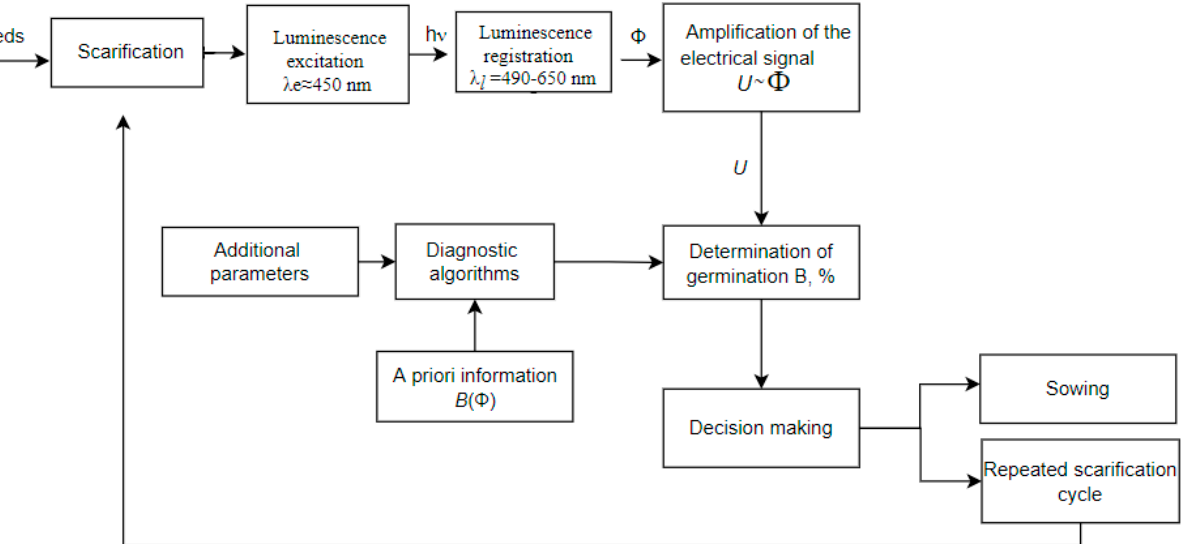
Figure 3. Block diagram of the technological process of express analyzing the scarification quality of forage plant seeds.